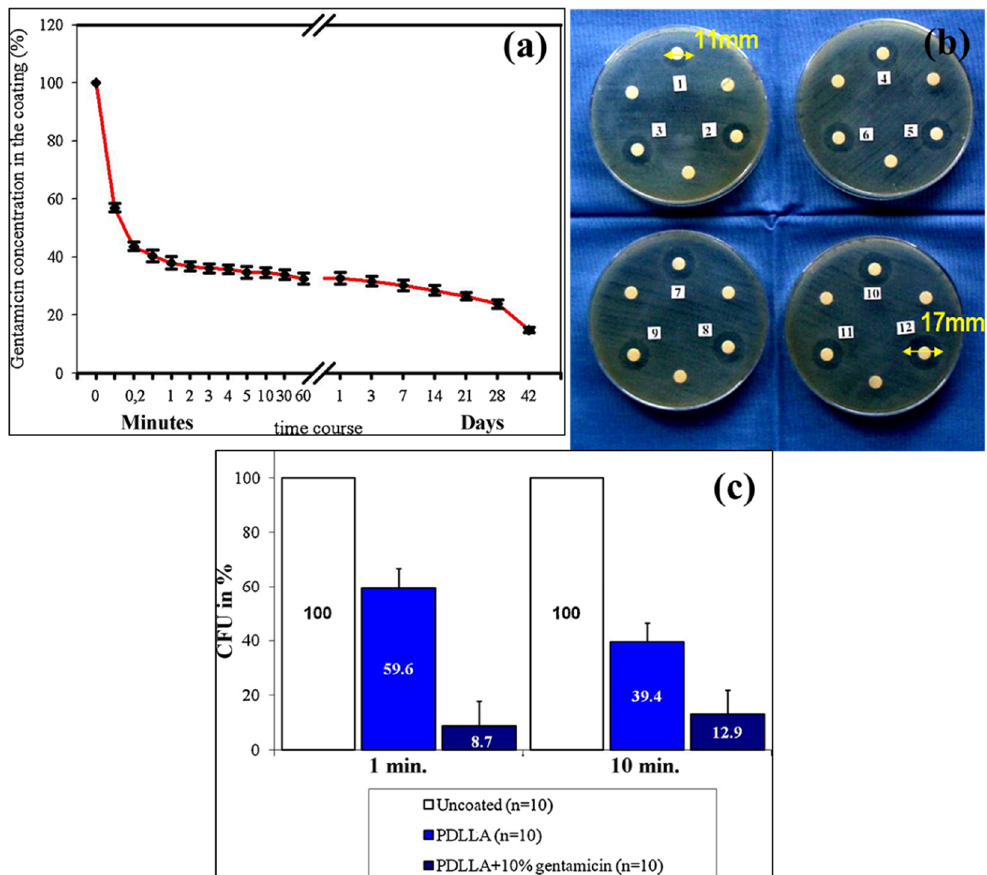
Figure 19. ( a ) Gentamicin release in vitro for 42 days (mean values), ( b ) depicts the test sites of the agar diffusion test clearly with the zones of inhibition, ( c ) bacterial adhesion over nutrient agar plates: average CFU after rolling uncoated, PDLLA-coated and PDLLA + 10% gentamicin coated K-wires [70]. Reprinted with permission from [70]. © 2010 Elsevier.